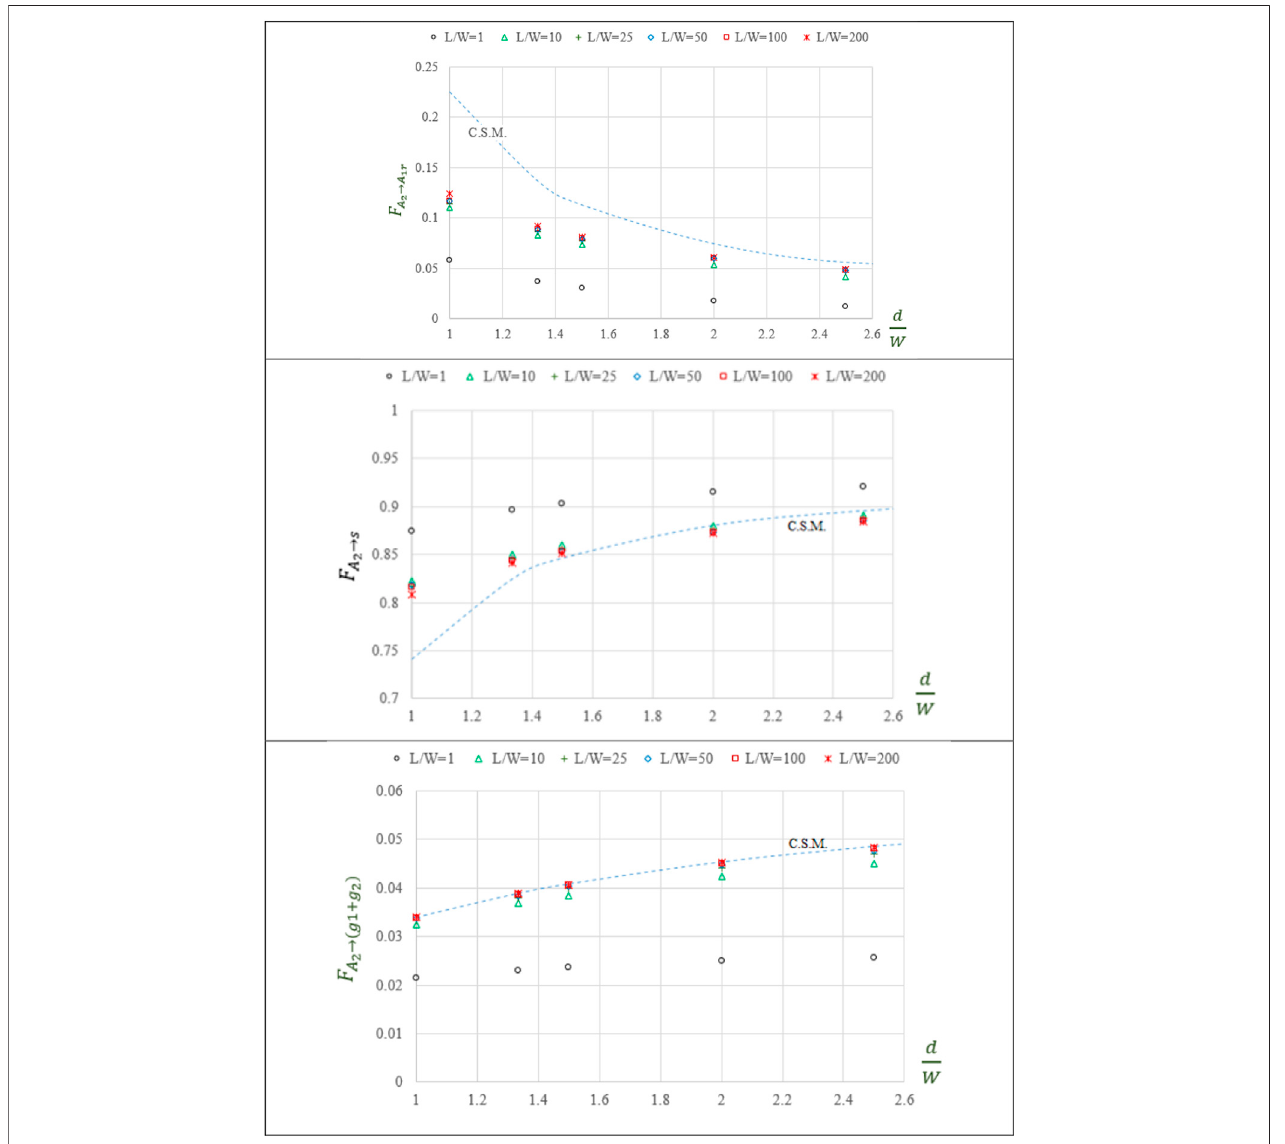
FIGURE13| Comparisonofviewfactorsofsurface F A